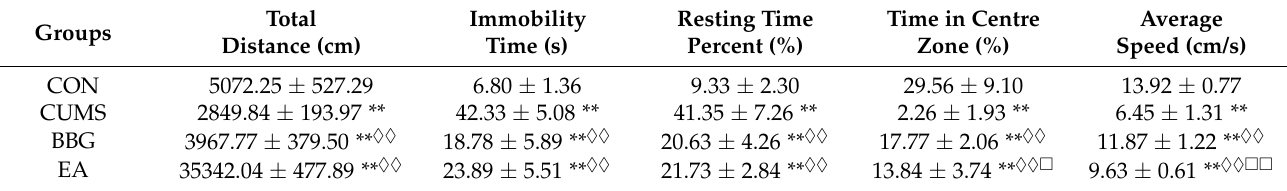
Table 4. Effects of EA on OFT and FST (n = 10; x ± s; cm, s, %,